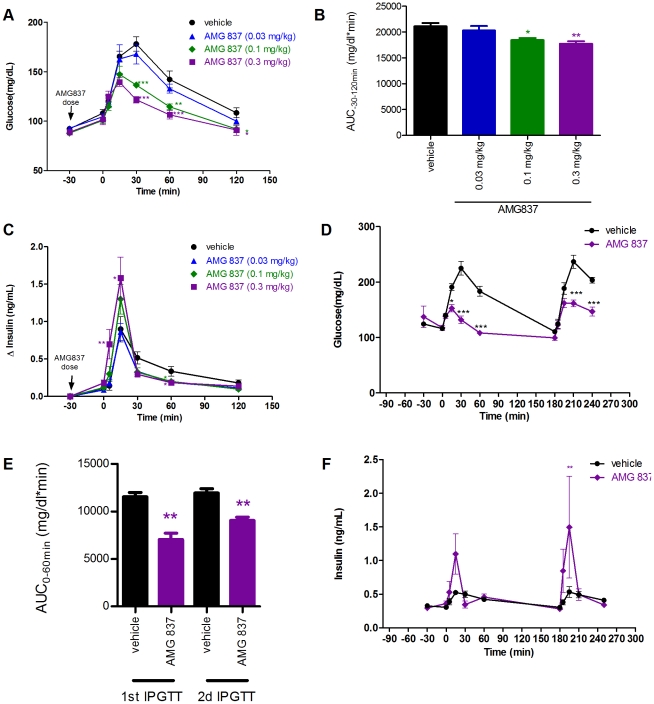
Improvement in glucose tolerance and potentiation of insulin secretion in Sprague-Dawley rats treated with AMG 837.8-week old Sprague-Dawley rats were treated with a single bolus of AMG 837 (at 0.03, 0.1 and 0.3 mg/kg, n = 6/group) by oral gavage 30-minutes prior to an intraperitoneal glucose challenge at t = 0 minutes. (A) Blood glucose measurements were taken during prior to and following glucose challenge. Black circle = vehicle, blue triangle = 0.03 mg/kg AMG 837, green diamond = 0.1 mg/kg AMG 837 and purple square = 0.3 mg/kg AMG 837 (B) The glucose AUC (from −30 to 120 minutes) during the course of the experiments were calculated. (C) Plasma insulin levels were measured using ELISA. Black circle = vehicle, blue triangle = 0.03 mg/kg AMG 837, green diamond = 0.1 mg/kg AMG 837 and purple square = 0.3 mg/kg AMG 837 (D–D) Two successive glucose challenges were conducted in Sprague-Dawley rats following a single oral dose of vehicle (n = 4, black circle) or AMG 837 at 0.3 mg/kg (n = 4, purple diamond). AMG 837 was dosed at −30 minutes, and glucose was administered by ip injection at 0 and 180 minutes. Blood glucose (D), calculated glucose AUC (from 0–60 minutes following glucose challenge (E, black bars = vehicle, purple bars = 0.3 mg/kg AMG 837) and plasma insulin (F) were determined. Statistical significance is denoted by * (p<0.5), ** (p<0.01) and *** (p<0.001) as determined by one-way or two-way ANOVA.